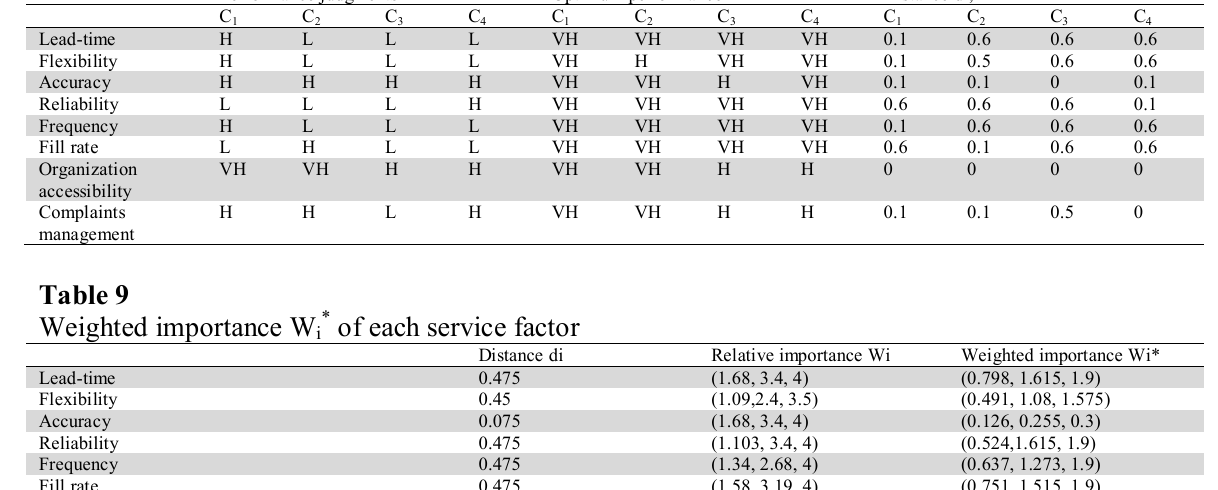
Distances d from the optimum performance and weighted importance Wi* of each service factor i